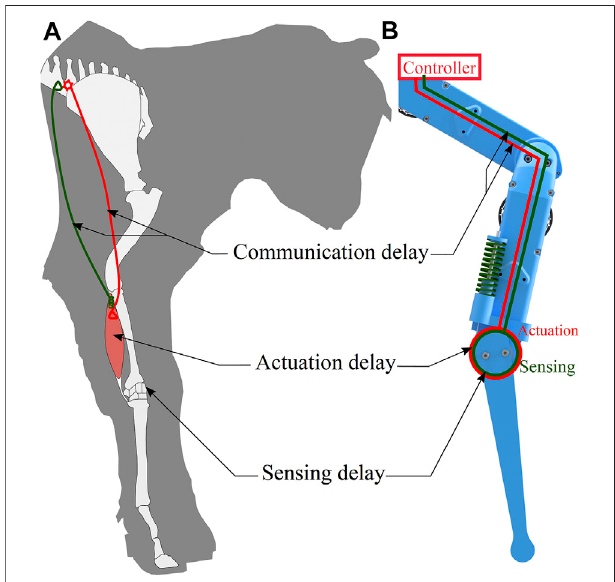
FIGURE 1 | (A) Animal locomotion control is subject to sensorimotor delays from sensing, communication, and actuation. The drawing is loosely inspired by Figure 1 of More and Donelan (2018). (B) Robots typically have lower intrinsic delays from electronic sensing and communication. Instead, delays are caused, for example, by fi ltering noisy data. We systematically tested robot controllers with varying sensorimotor delay and control frequency. We hypothesized that a hybrid system comprised of passive joint elasticity and parallel active joint stiffness can reject sensorimotor delays robustly, for appropriate compliance